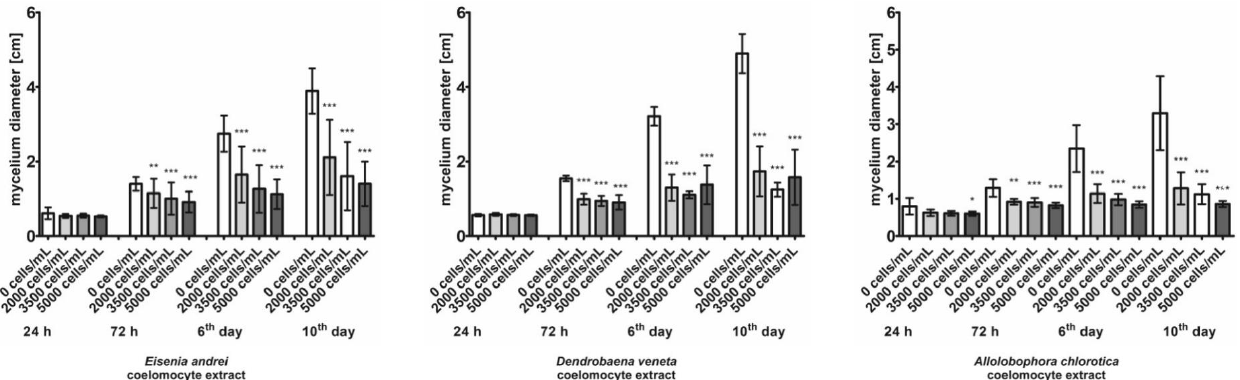
Figure 1. Growth (mean diameter ± SD) of Berkeleyomyces basicola mycelium 24 h, 48 h, 6 days and 10 days after treatment with Eisenia andrei , Dendrobaena veneta and Allolobophora chlorotica coelomic fluid extracts. Significant differences between control and groups treated with coelomocyte extracts are labeled with * ( p < 0.05), ** ( p < 0.01) and *** ( p < 0.001).